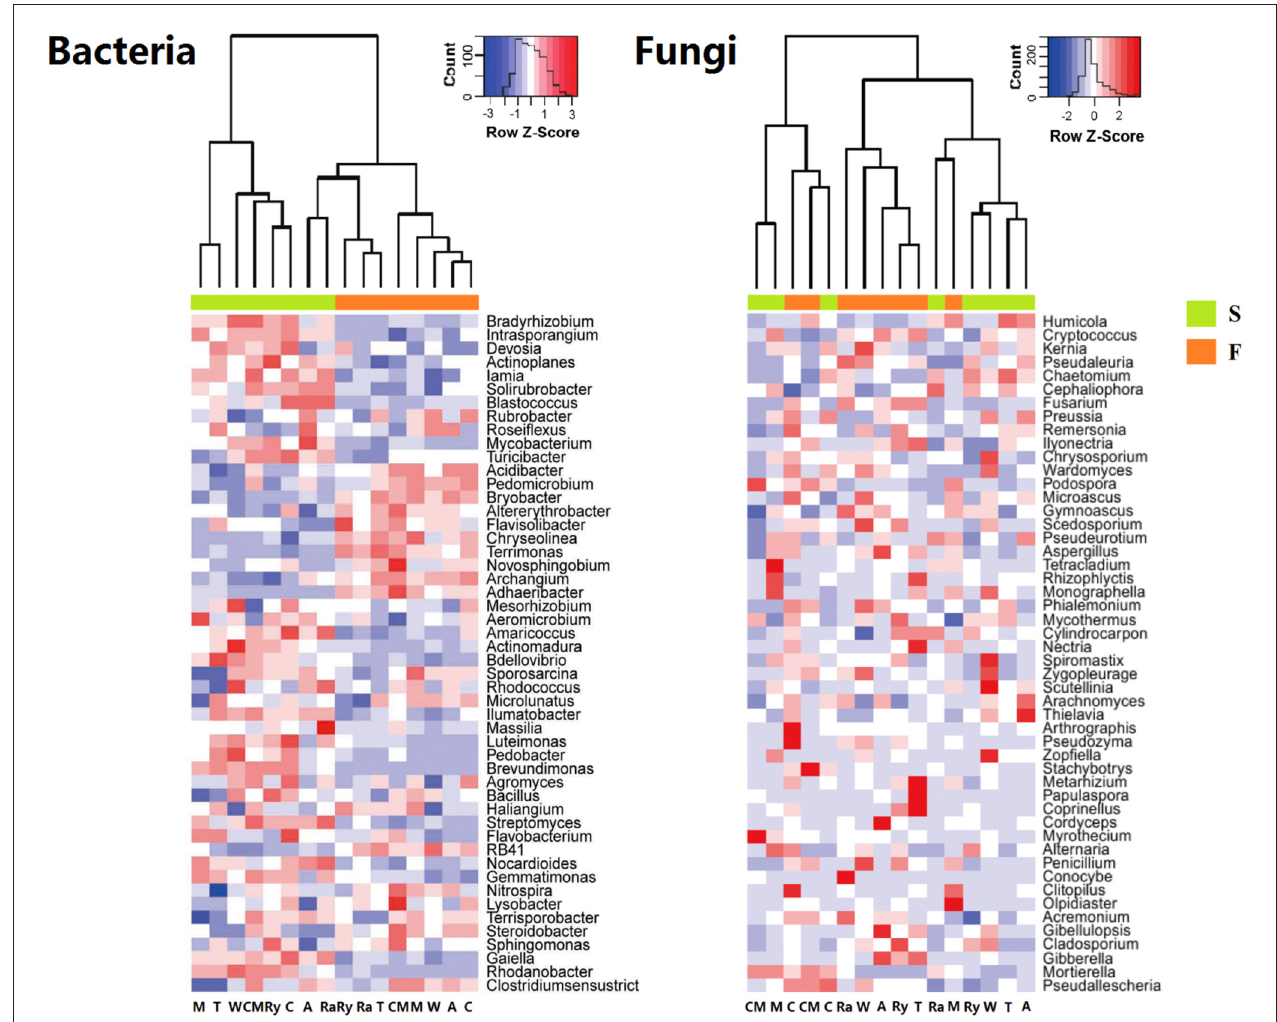
FIGURE 3 | Heatmap of top 50 genera of soil bacterial and fungal communities in the spring (S) and fall (F) cropping seasons. Legends showed the Z-scores, demonstrating all samples were represented by the median-centered Z-scores as the relative abundance